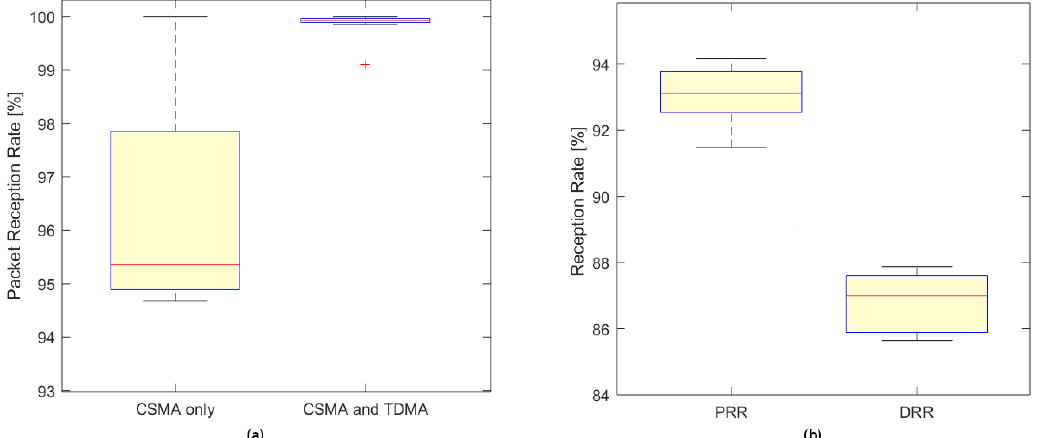
Figure 5. Packet reception rate (PRR) during normal operation ( a ) and PRR/DRR values under heavy traffic ( b